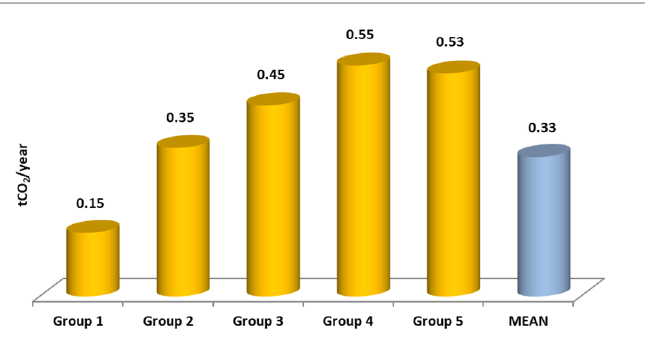
Figure 16. Mean CO 2 emissions per inhabitant by group of cities without the influence of climate.